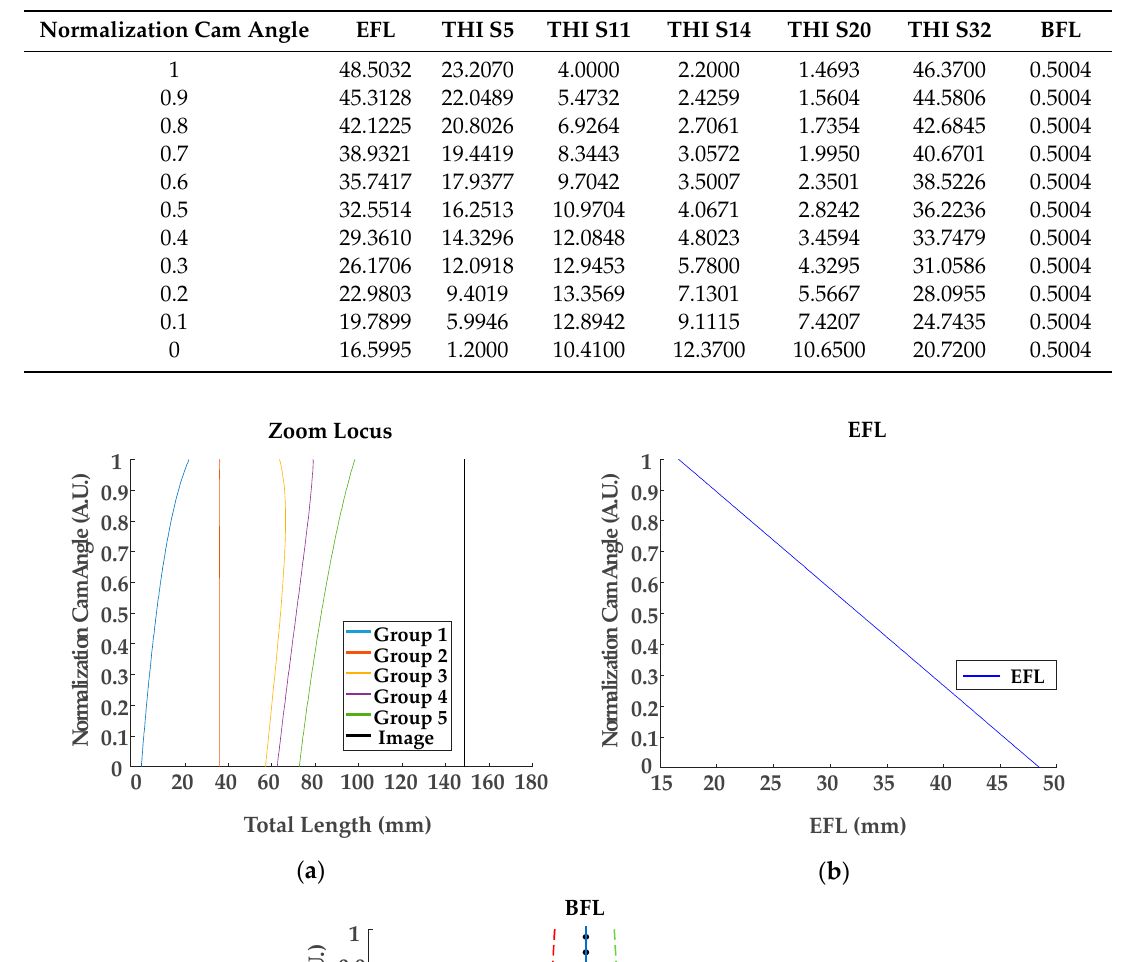
Table 6. Result of correcting the error for the image plane and EFL by moving the first and fourth lens groups.